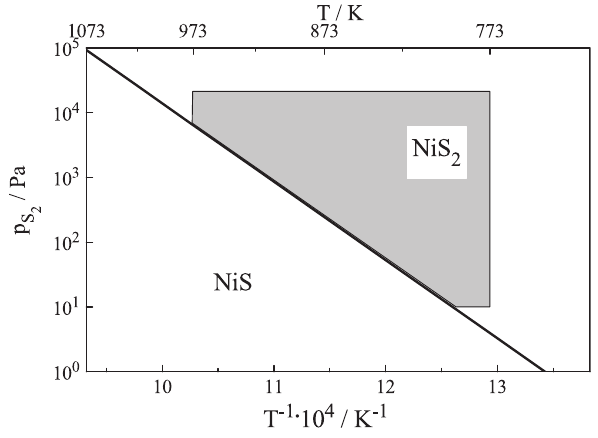
Fig. 1: The part of phase diagram of Ni-S system, illustrating the temperature and sulphur vapor pressure ranges, in which the sulphidation rate measurements have been carried out (dashed